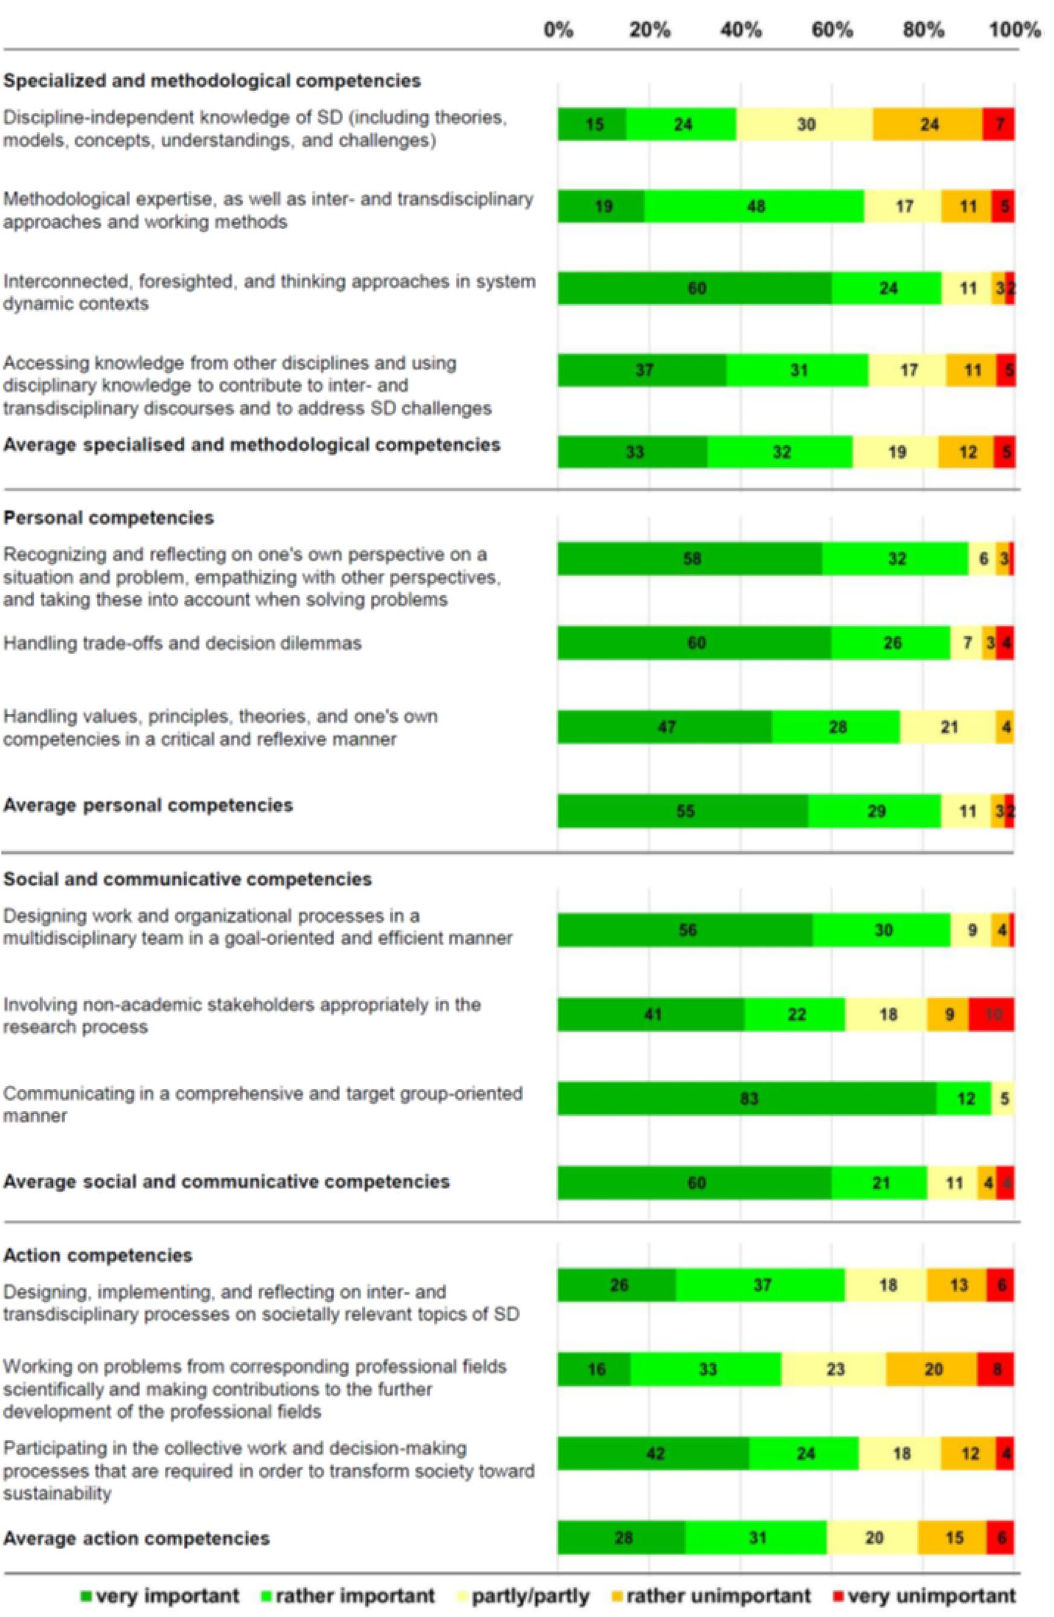
Fig. 10 Average regarding the assessment of the importance of the competencies of all three groups surveyed and the categories in % (students: importance for intended professional activity; graduates: importance for current professional activity; and internship supervisors: importance for their professional